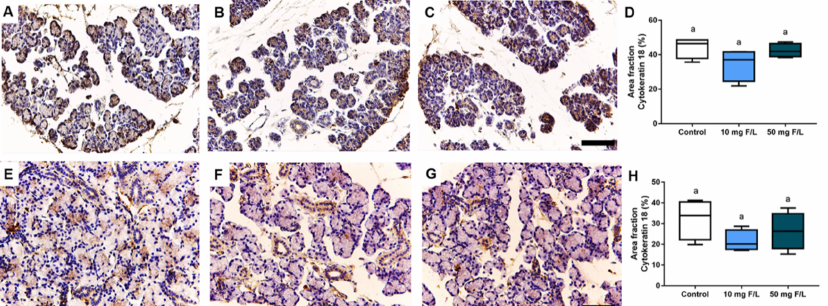
Figure 4. Immunohistochemical analysis of cytokeratin-18 of the tissues that comprise the parotid and submandibular glands of the offspring indirectly exposed to water containing 0 (control), 10, or 50 mg F/L for 42 days ( n = 5 animals/group). ( A – C ) represent the parotid glands of the control, 10 mg F/L, and 50 mg F/L groups, respectively; in ( D ), the area fraction of the parotid gland; in ( E ), submandibular of the control group; in ( F ), submandibular in the 10 mg F/L group; in ( G ), submandibular in the 50 mg F/L group; in ( H ), the area fraction of submandibular gland. Quantitative results are expressed as mean ± standard error, one-way ANOVA with Tukey’s post-test. Different letters indicate statistical difference ( p < 0.05). Scale bars: 10 µ